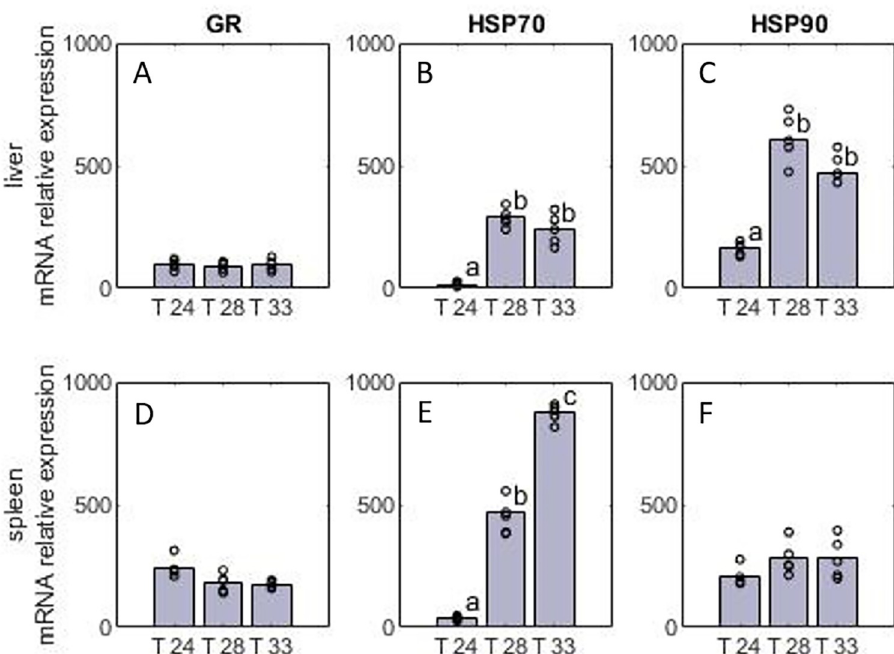
Fig 6. Relative expression of three target genes for E. sea bass reared under three temperatures (T-24, T-28, T-33). A, B, C: the relative expression of GR, HSP70, and HSP90 in the liver. D, E, F: the relative expression of GR, HSP70, and HSP90 respectively in the spleen. Statistically significant differences among treatments are indicated with different letters (one-way ANOVA) while points represent individual measurements (N = 5 per